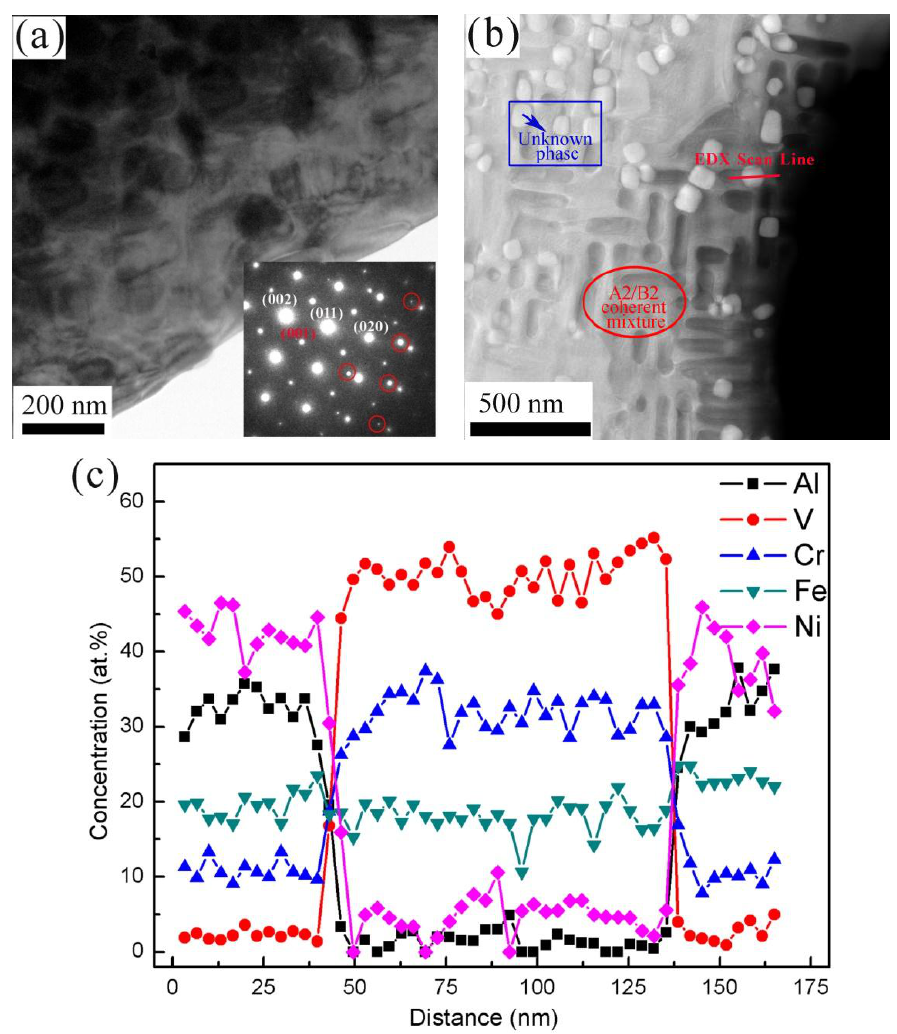
Figure 3. ( a ) BF TEM image of the Al 0.3 CrFeNiV alloy and corresponding SAED patterns (zone axis [100]) showing the alloy consisted of a B2 phase, and an A2 phase; ( b ) STEM-HAADF image, where the red line indicates the EDX scan line; ( c ) Compositional profiles across the nano-precipitates.